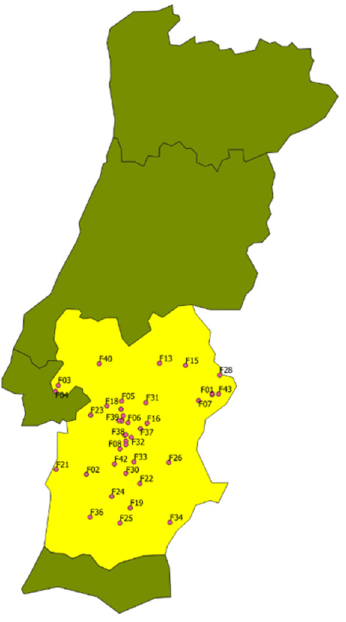
Figure 1. Location of surveyed farms within the Alentejo region (NUTS II), Portugal.